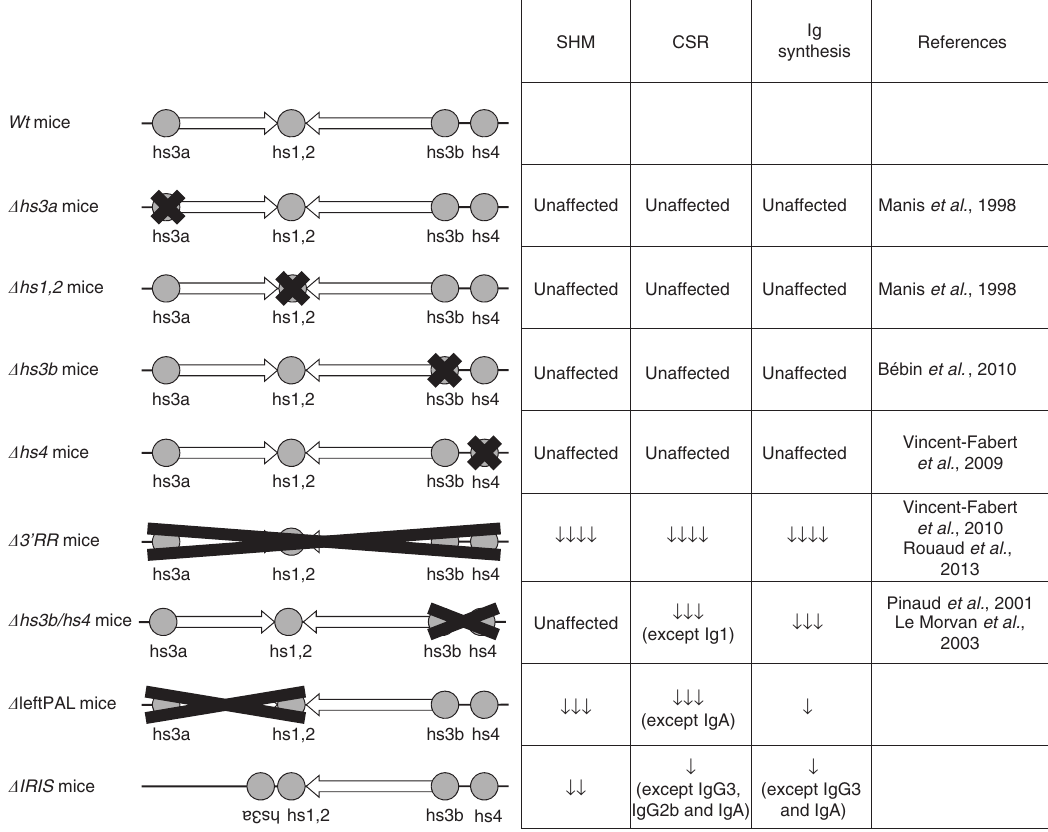
intact in D IRIS mice prevented the fall in histone modification and RNA pol II pausing but nevertheless affected AID recruitment in V H genes. Taken together, this indicates that, even when all enhancer elements were present, breaking the palindrome symmetry by deleting half of inter-enhancer intervening sequences plus flipping hs3a in a direct repeat orientation affected SHM at a level similar to D leftPAL mice also lacking hs3a and hs1,2 . Although a role for the non-conserved